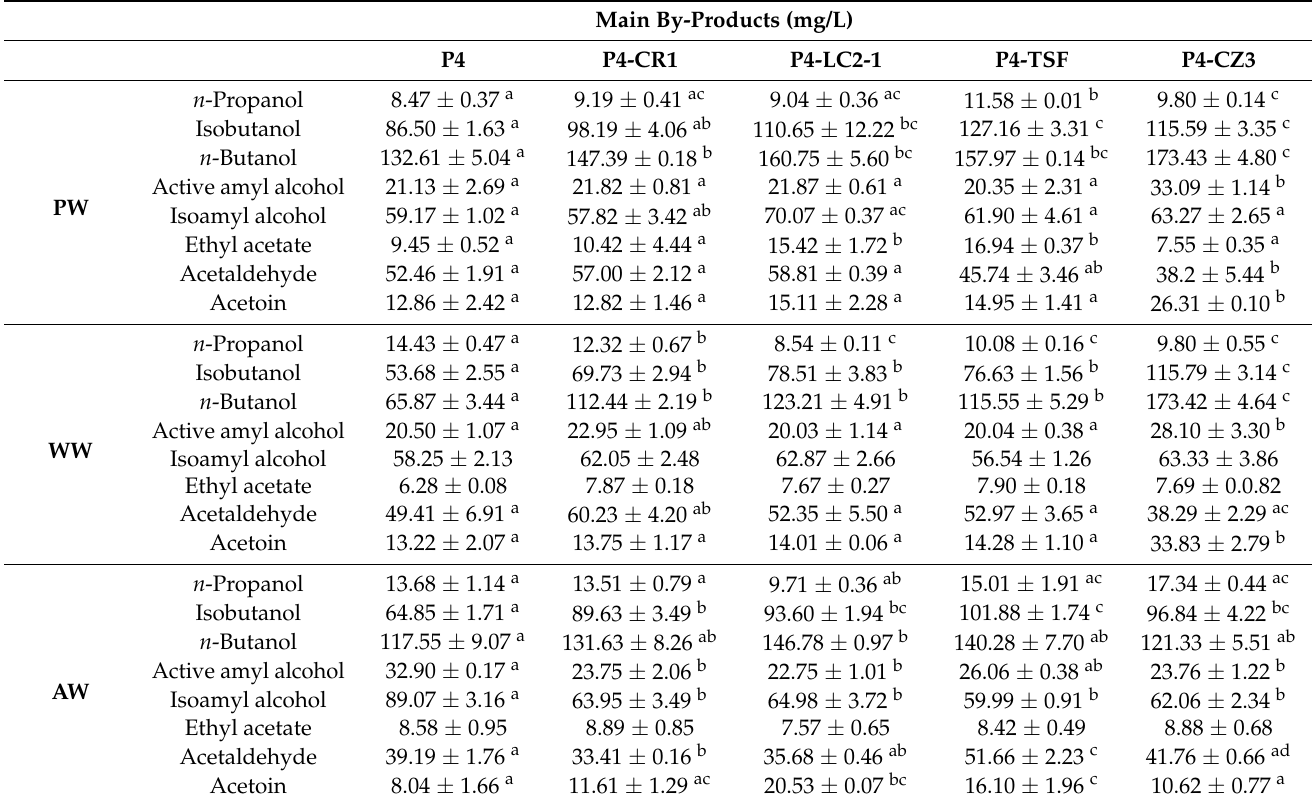
Table 3. Main by-products determined in the experimental beers produced by pure (P4) and mixed cultures (P4-CR1, P4-LC2-1, P4-TSF, P4-CZ3) in the three different worts (PW, WW and